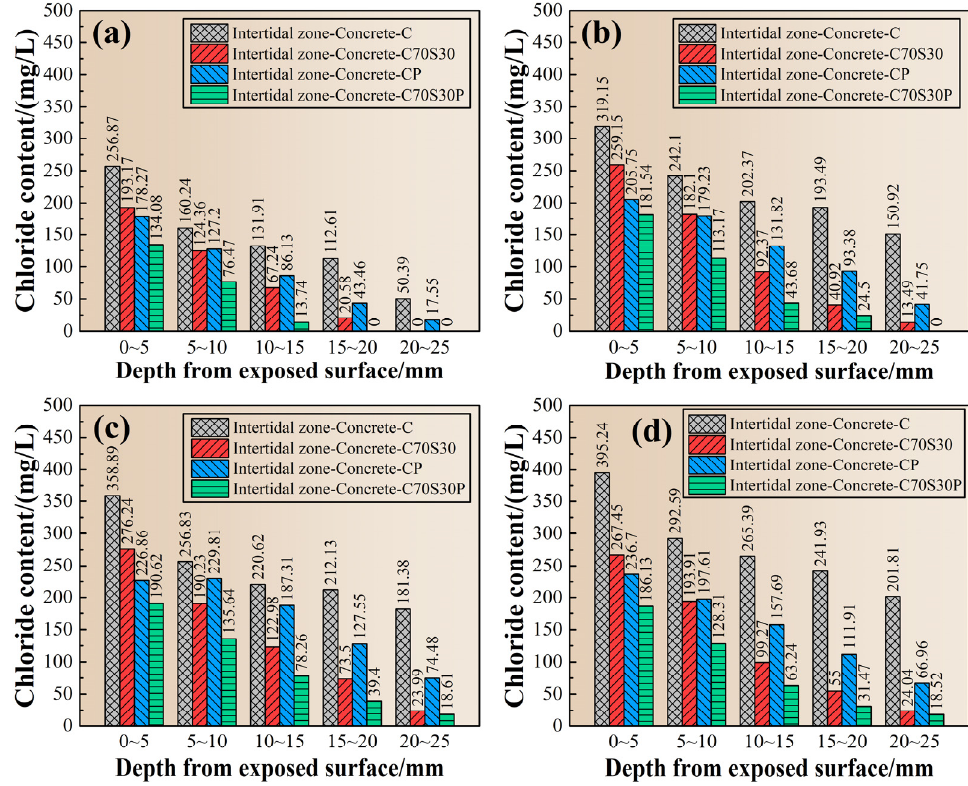
Figure 15. The chloride ions’ profile of CBRM-Concrete serving in the intertidal zone simulated environment. ( a ) 18 + 30 days, ( b ) 18 + 60 days, ( c ) 18 + 90 days, and ( d ) 18 + 180 days.